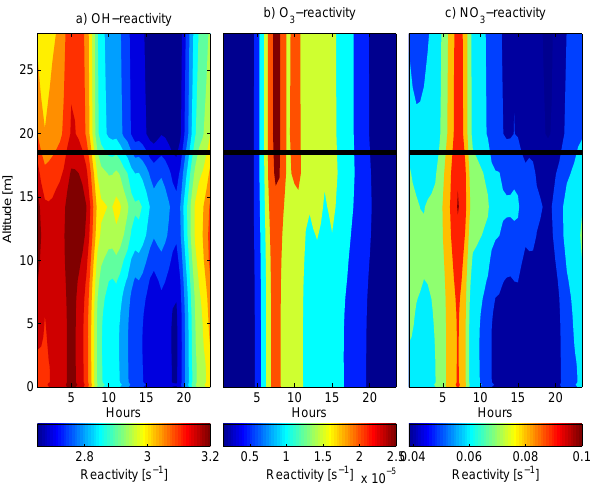
Figure 9. Daily averaged vertical total reactivity of OH (a) , O 3 (b) , and NO 3 (c) . The top of the Figure 12. Daily averaged vertical total reactivity of OH (a) , O 3 (b) canopy is indicated by a black solid line. and NO 3 (c) . The top of the canopy is indicated by a black solid line.